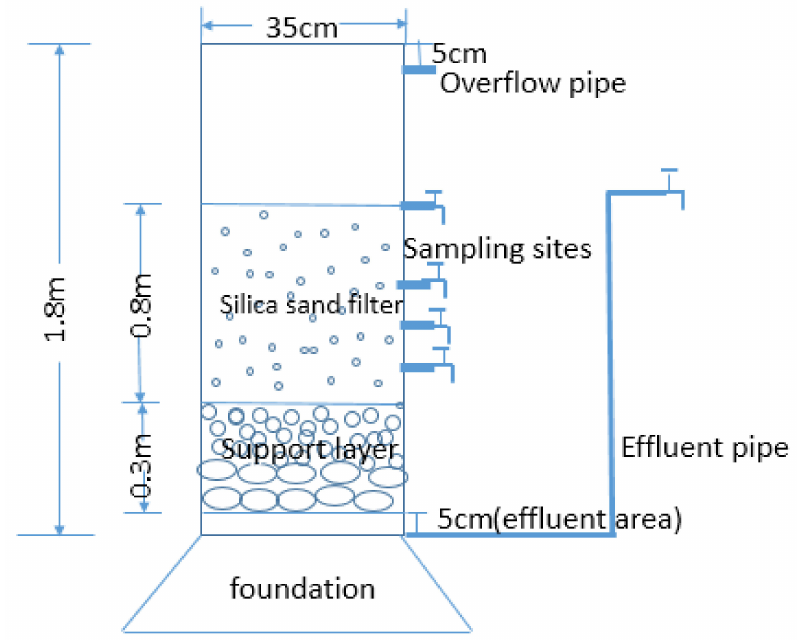
Figure 1. Design of biological slow